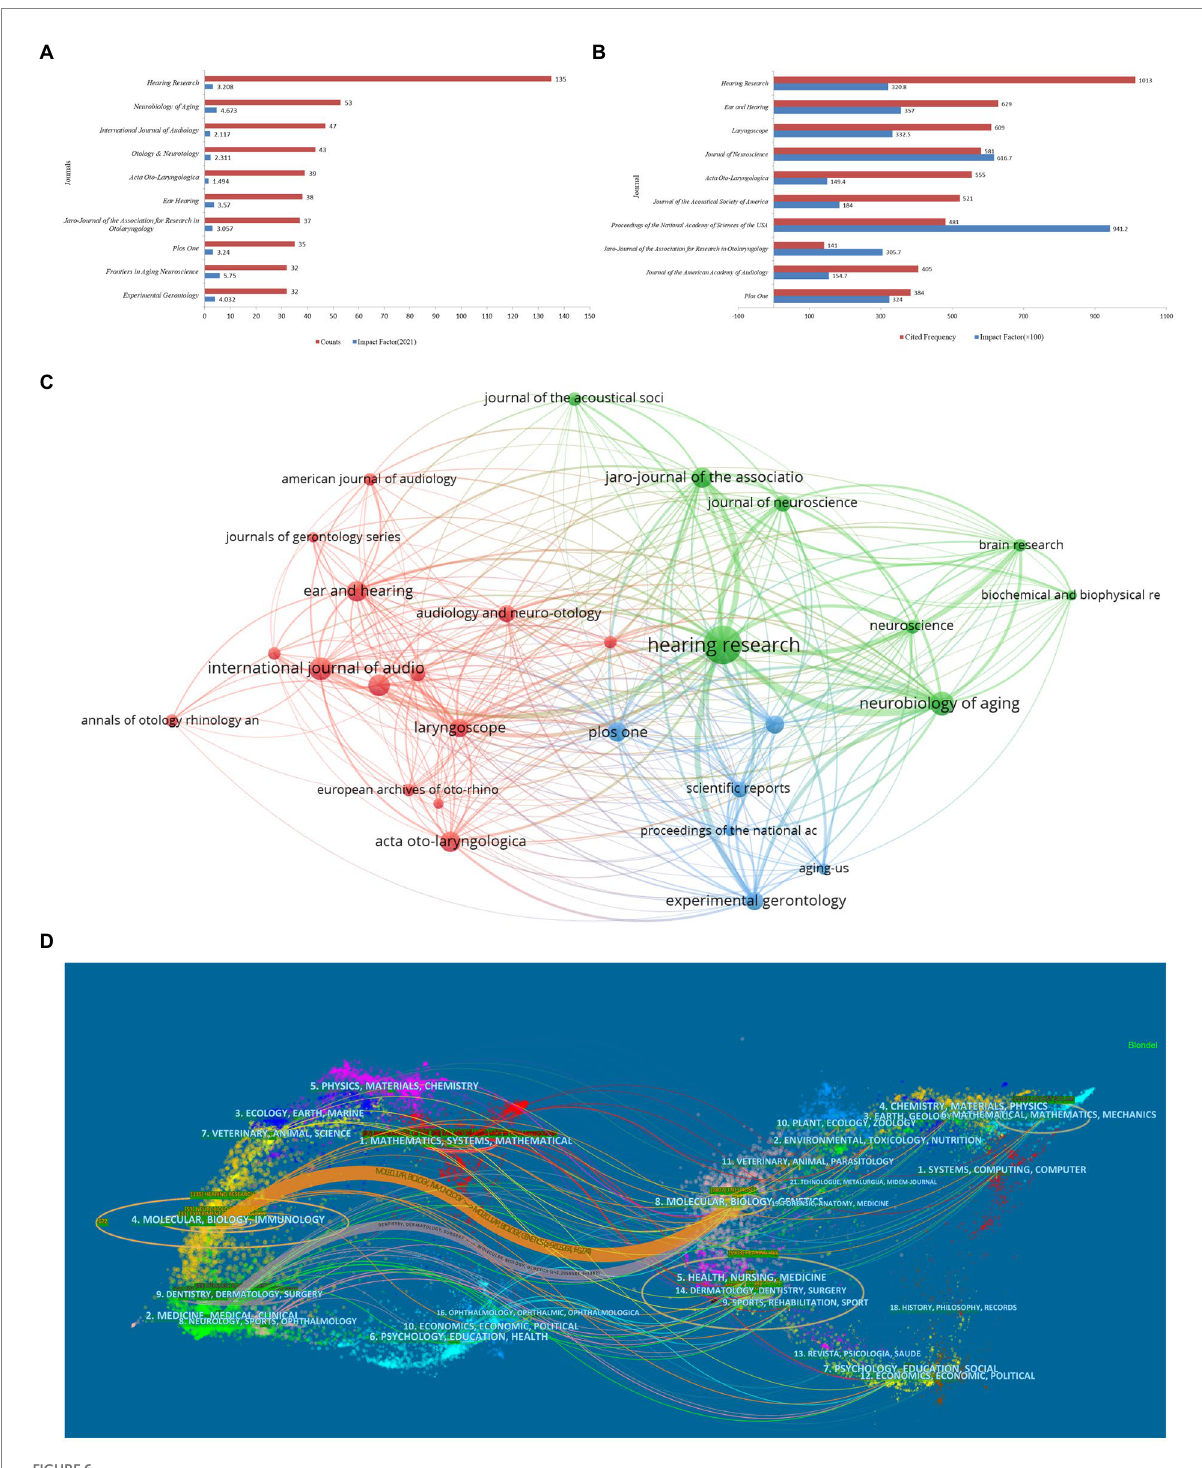
FIGURE 6 Top 10 leading journals related to aged-related hearing loss research from 2002 to 2021 (A) . Top 10 co-citation journals (B) and a network map (C) . Dual-map overlays of discipline and journal analysis (D)